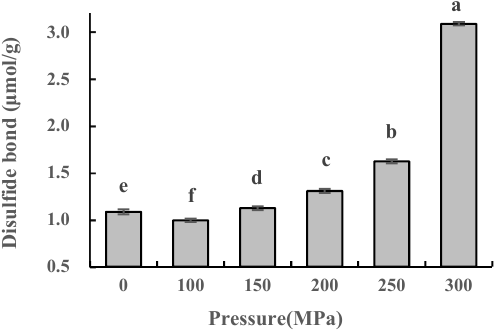
Figure 3. Disulfide bond content of casein under different pressure conditions. Different superscript letters within a column indicate significant differences between means ( p < 0.05).